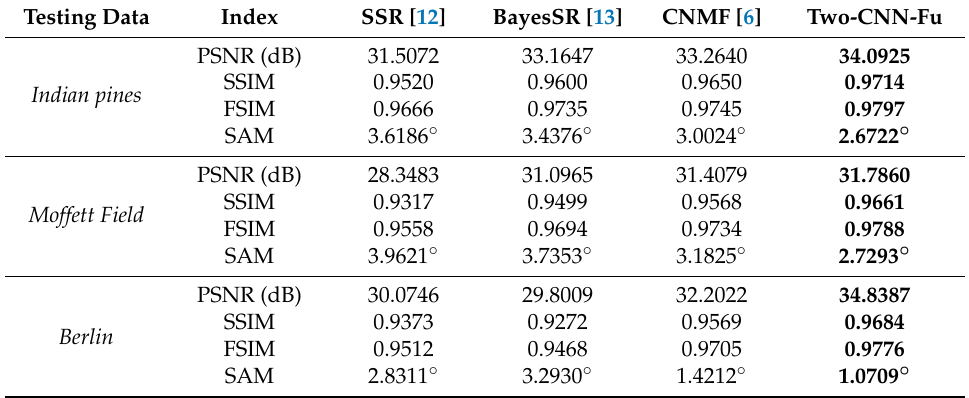
Table 3. The evaluation indices of different fusion methods on the three testing data by a factor of two.